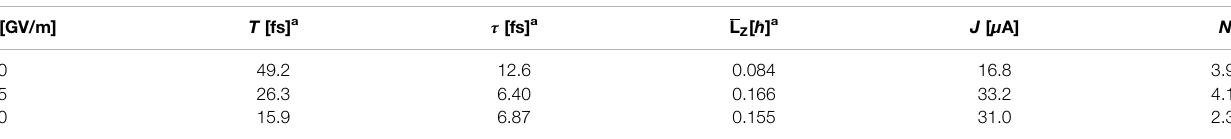
a Parameters V, Δ , Ω , ω a , and ω b , were calculated for three values of F using Eq. 34 . These parameters used for the calculation of the following physical quantities: T as a period of Rabi oscillation; L Z is the angular momentum averaged over one cycle period of Rabi oscillation, τ (cid:2) 2 π m e r / p (cid:2) 2 π m e r 2 / N r ≡ T/ τ as one cycle count of π -electron